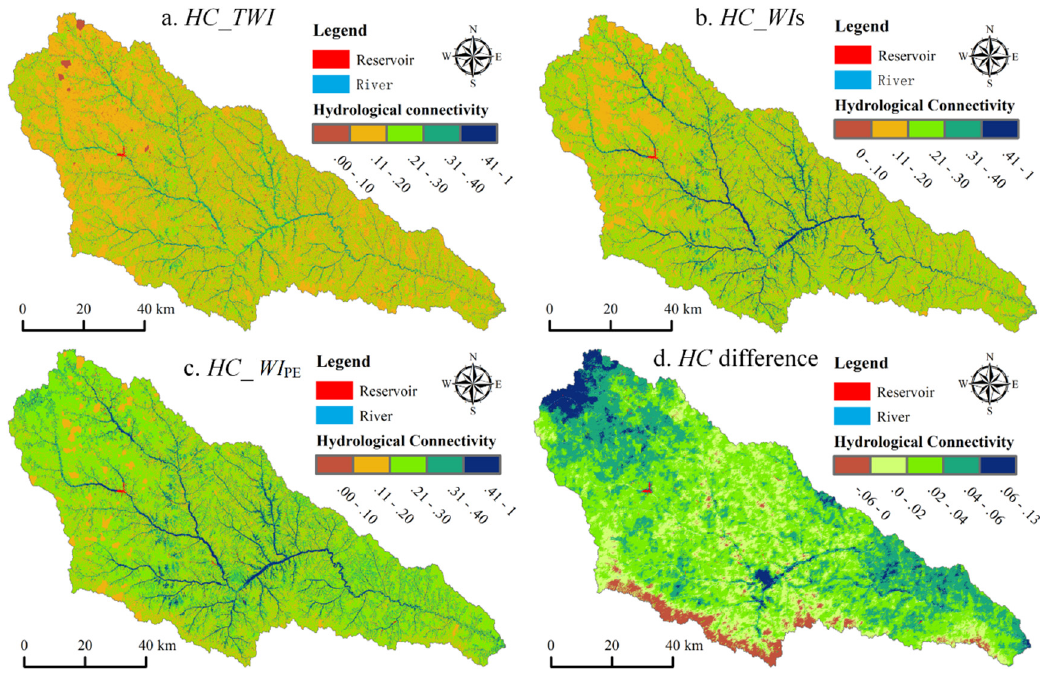
Figure 5. Spatial pattern of hydrological connectivity HC_TWI ( a ), HC_WI S ( b ), HC_WI PE ( c ), which calculated by TWI , WI S , and WI PE , respectively, and the difference between HC_WIPE and HC_WIS ( d ) in the Yan River watershed.